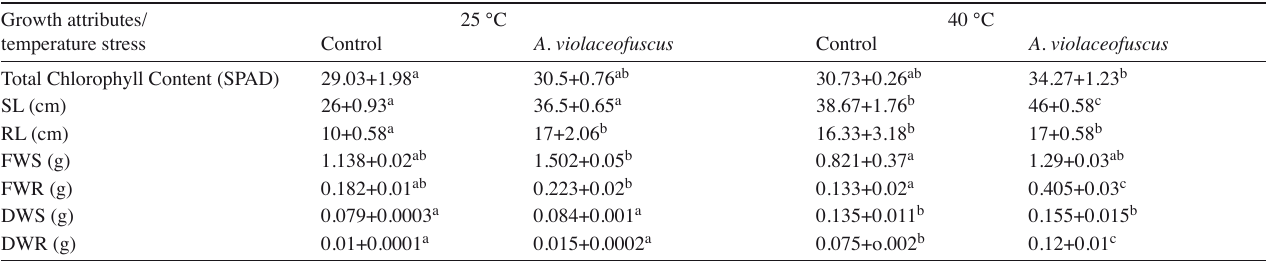
Tab. 2: Influence of A. violaceofuscus on the growth attributes of G. max